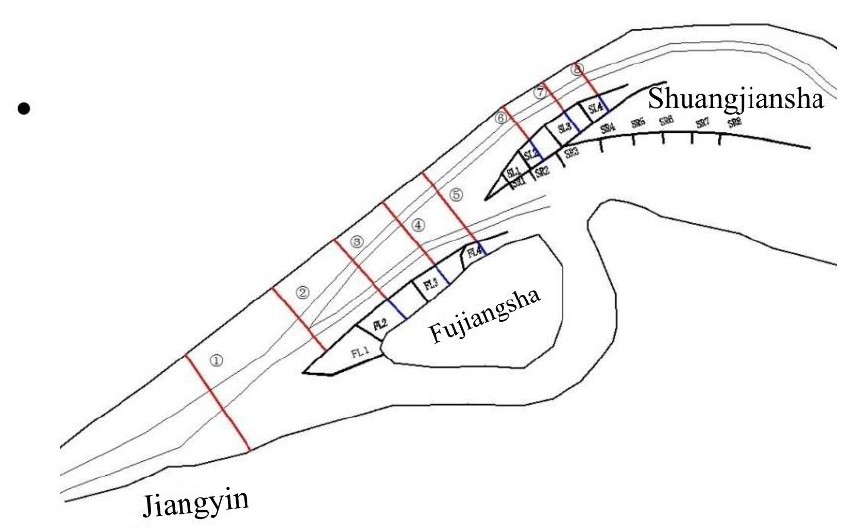
Figure 11. Positions of the sections in Fujiangsha Waterway after the project.